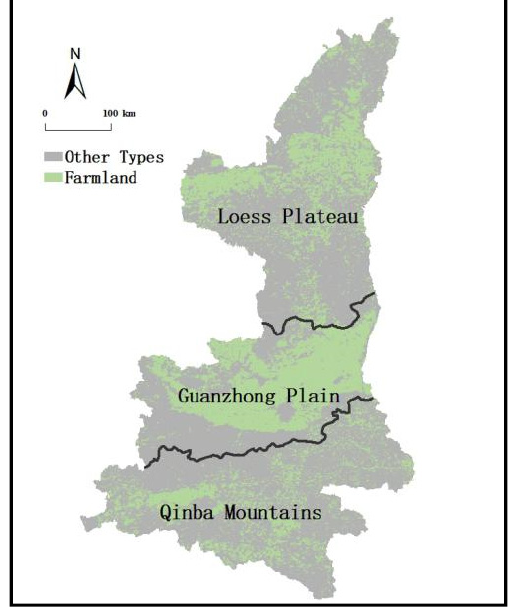
Figure 1. Farmland distribution in Shaanxi Province (2018).